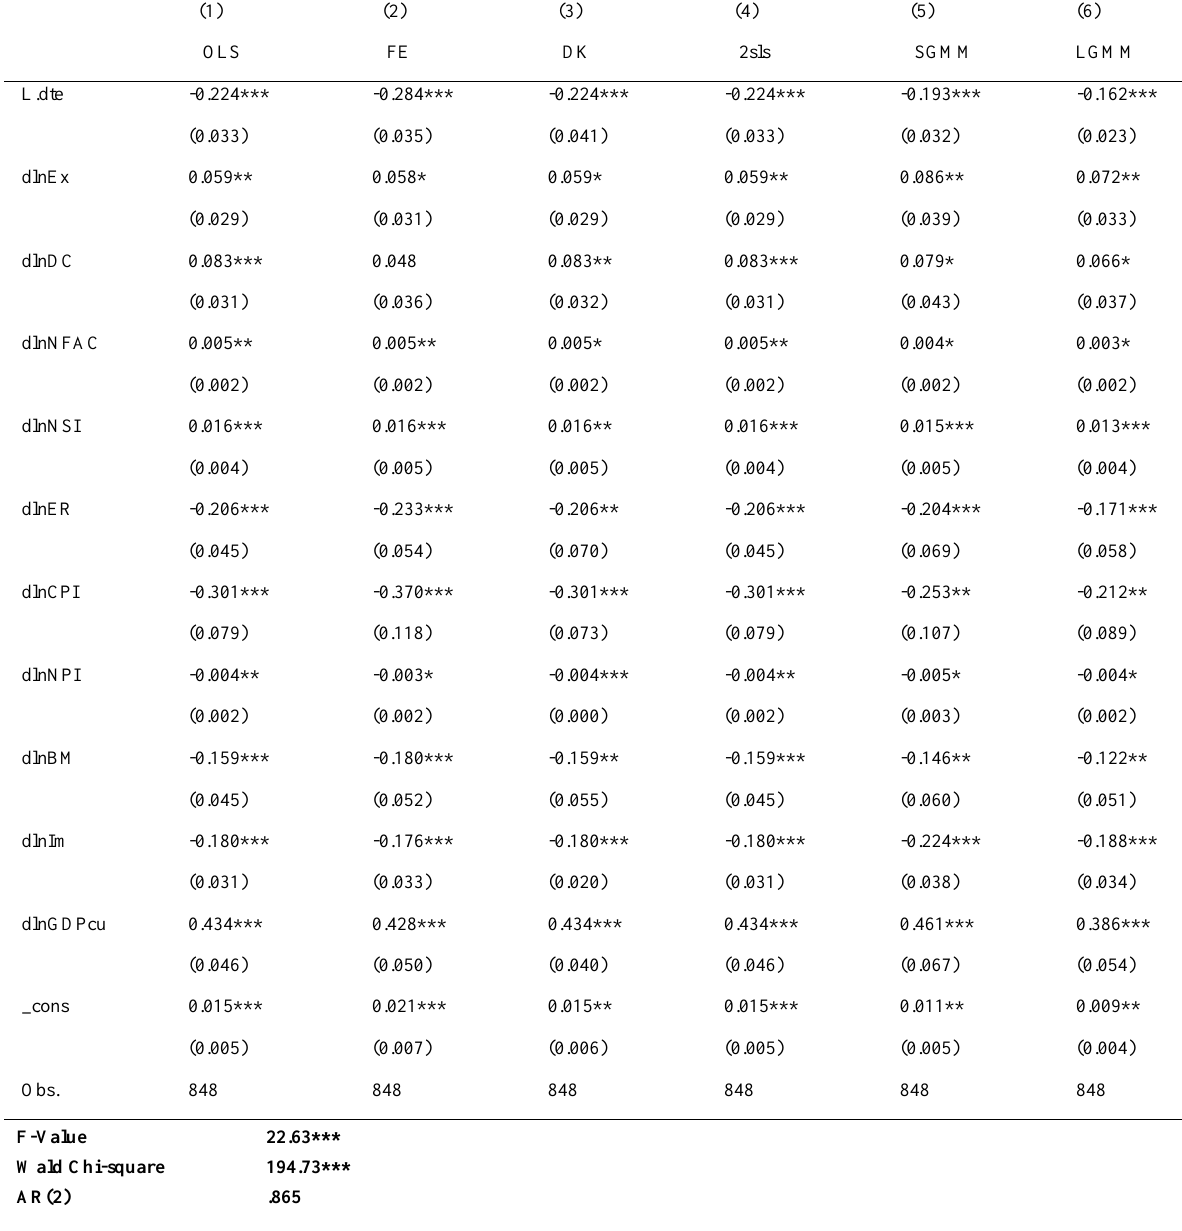
Table 13: Determinants of wealth maximizing technical efficiency with PRR